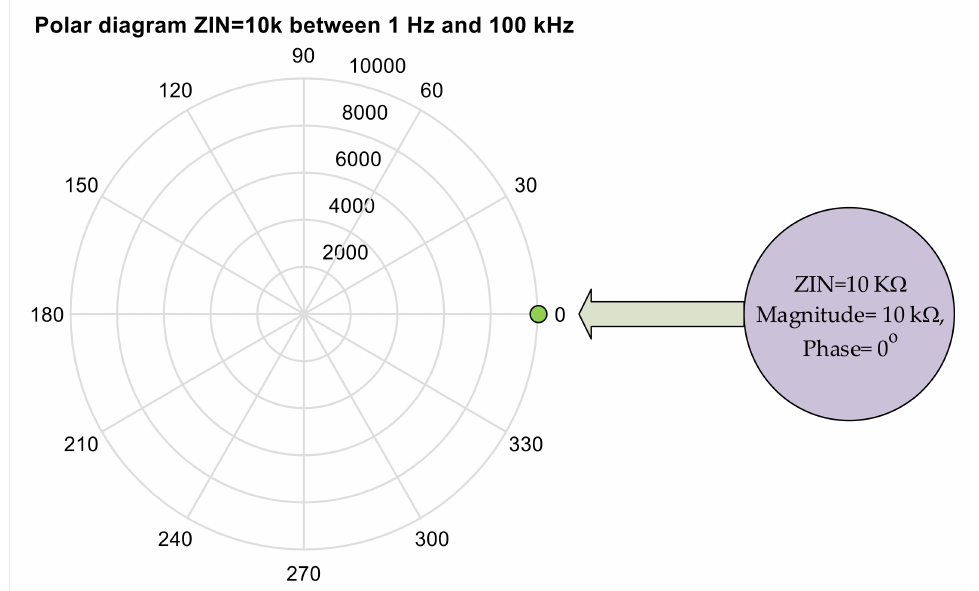
Figure 1. Polar diagram: Complete sweep from 1 Hz to 100 kHz with ZIN = 10 K Ω (Magnitude 10 k Ω , Phase 0 ◦